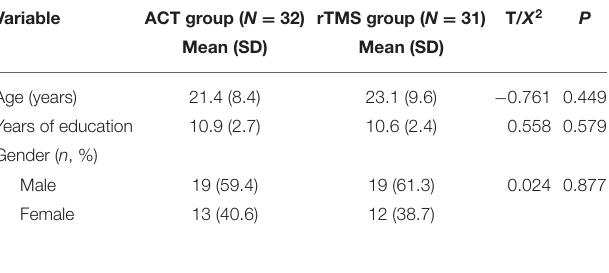
TABLE 1 | Demographic characteristics for two groups.